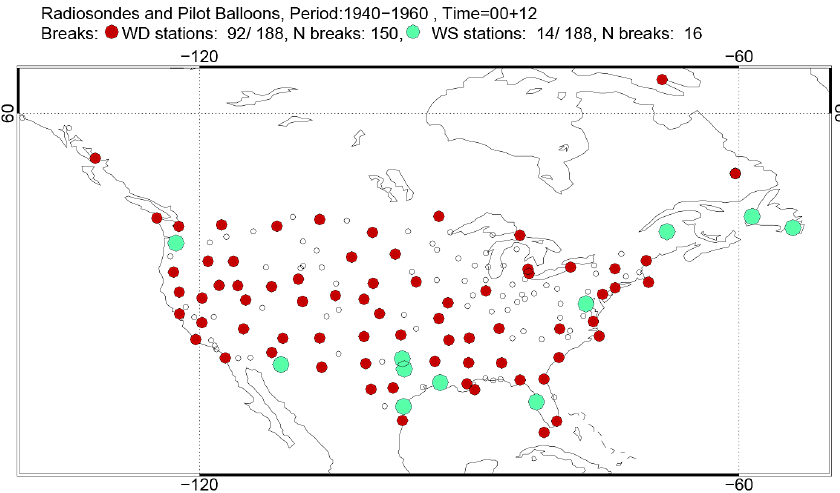
Figure 13. Stations with breaks in wind direction (red bullets) and speed (green bullets) for the period 1940–1960, as well as stations with no breaks (open circles). 188 stations with at least 10 years of observations were analyzed. For wind direction, 92 stations show 150 breaks in this period, whereas only stations with 16 wind speed breaks were